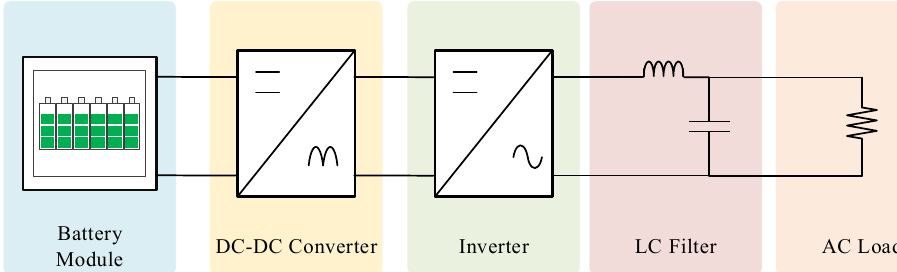
Figure 3. Pseudo DC-link topology of a BESS.